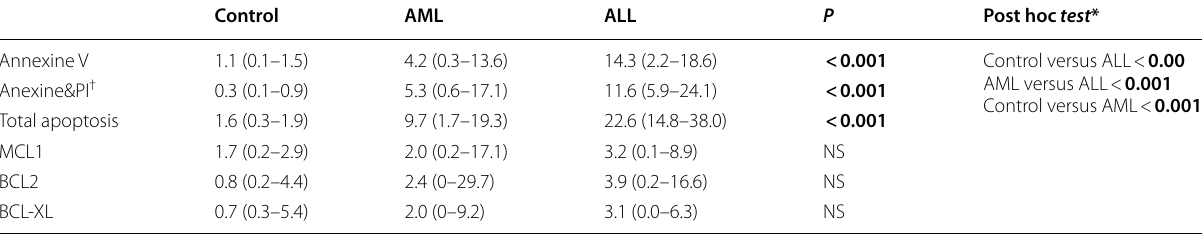
Results are expressed as medians and ranges. Kruskal–wallis tests with Dunn–Bonferroni post hoc method were applied *Results of the post hoc test were the same for all apoptosis indices